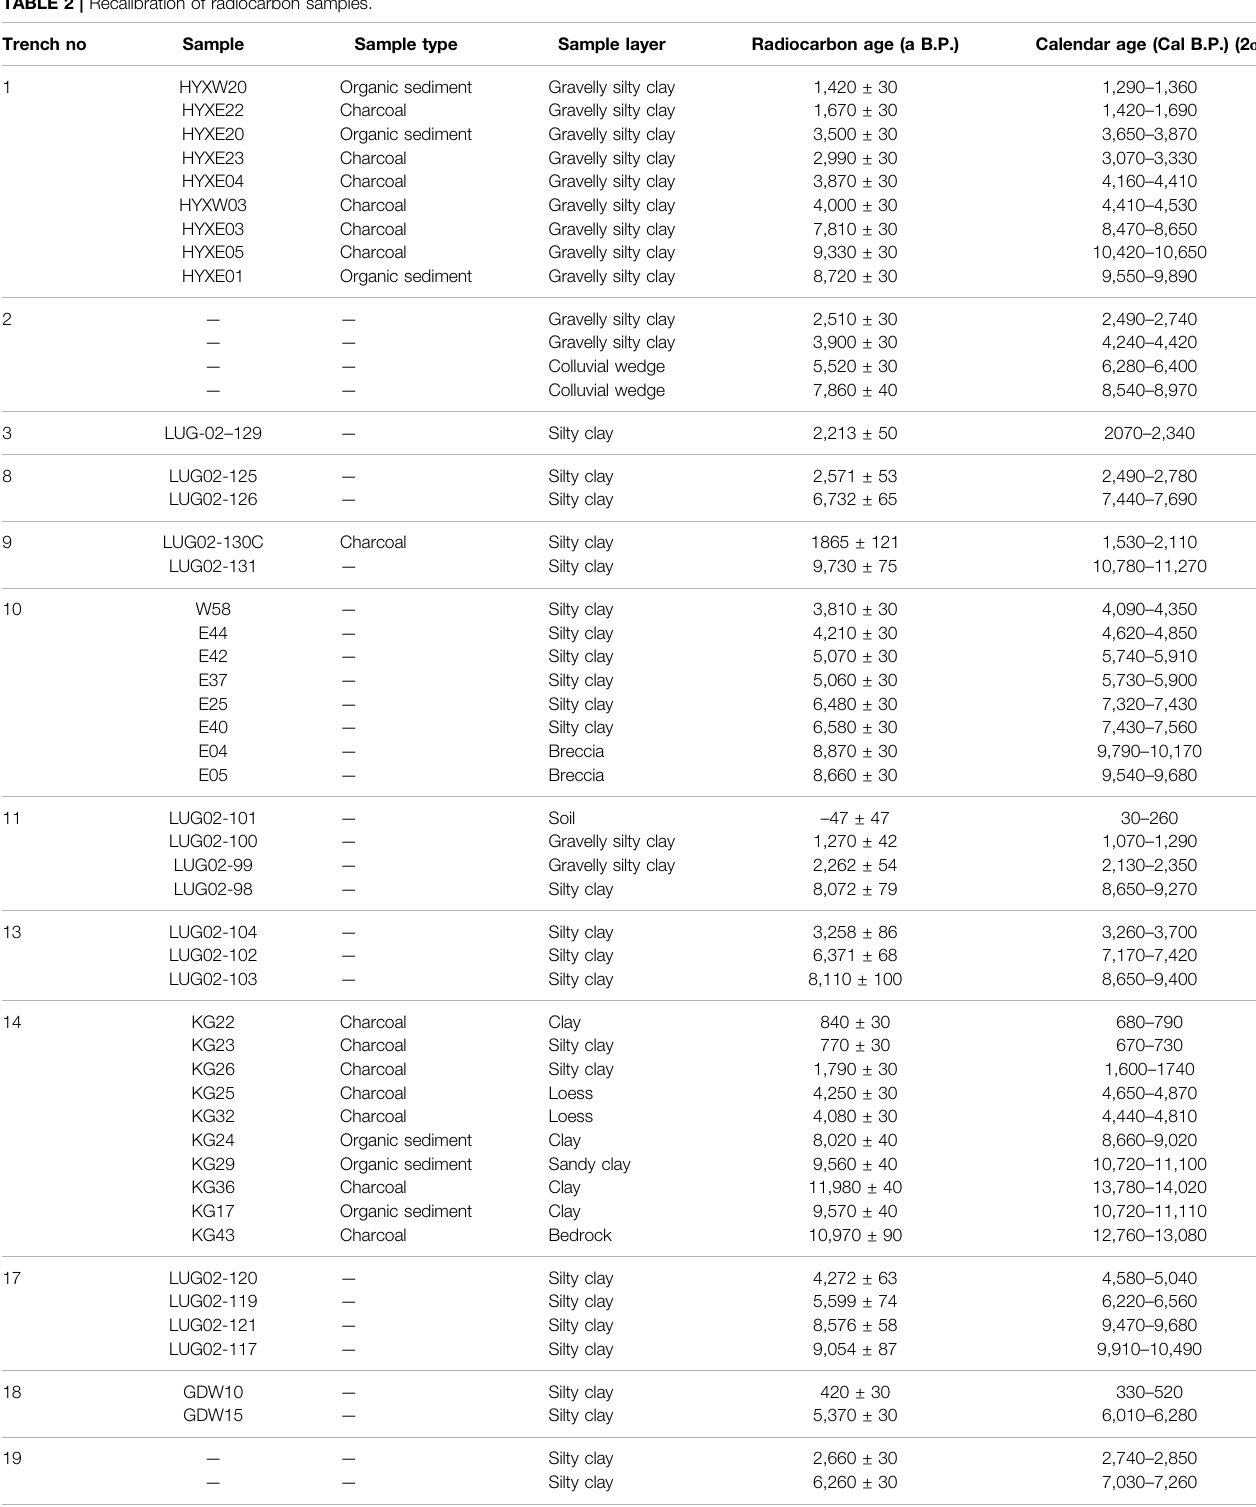
TABLE 2 | Recalibration of radiocarbon samples. Trench